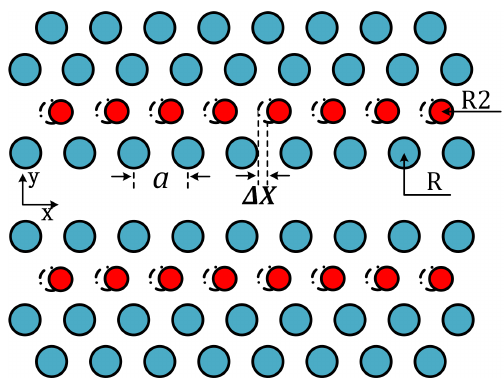
Figure 1. Schematic of the dispersion engineering slow-light Si-PhCW, the blue circles represent the air-holes in a standard W1 PhCW with a lattice constant of a , while the red circles represent the engineered air-holes, i.e., decreasing the radius from R to R2 and shifting horizontally from the dashed circles by ∆ x .